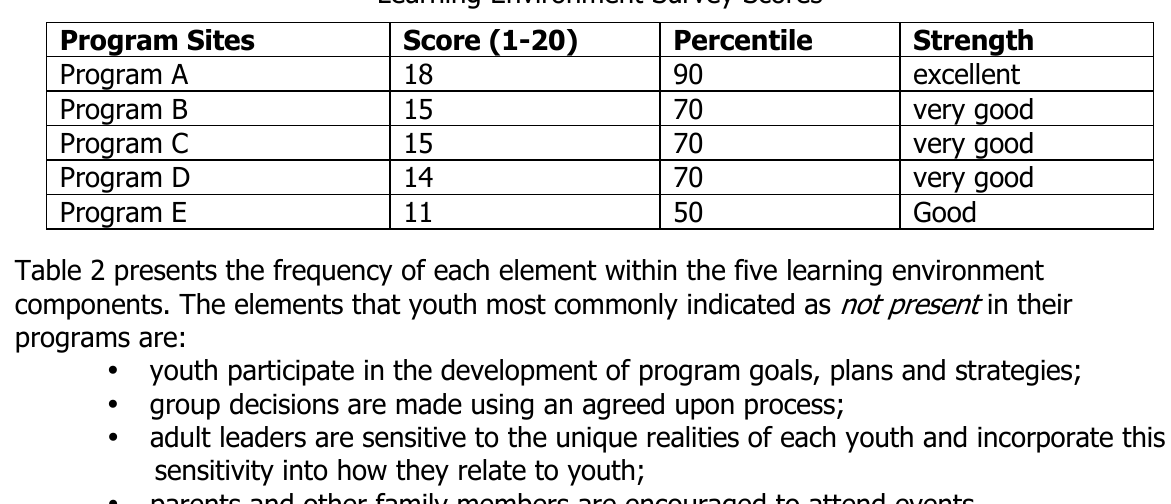
Learning Environment Survey Scores